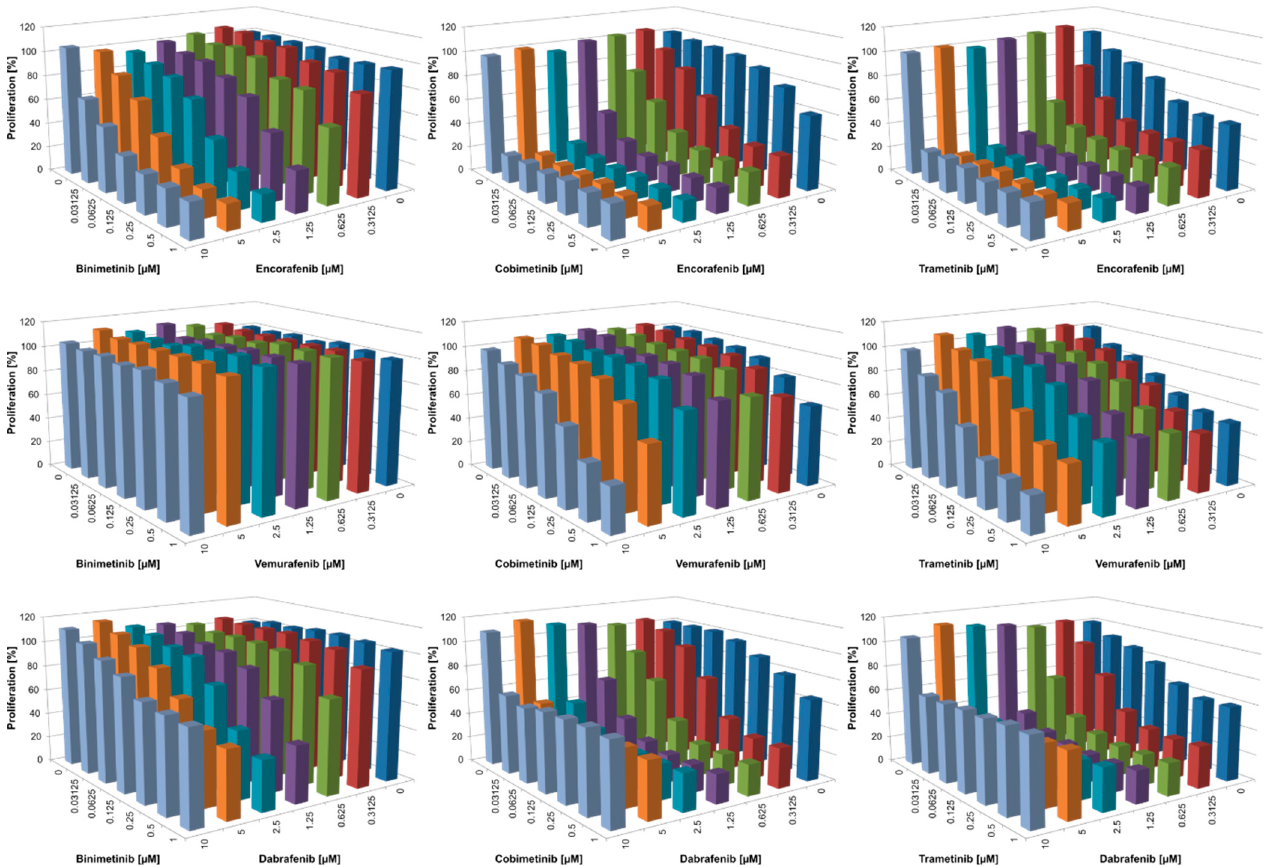
Figure 5. Inhibition of proliferation of WM1366 (NRAS mut ) after treatment for 72 h with single or combined BRAFi/MEKi (serial dilutions 1:2); n ≥ 3; for simplicity, standard deviation and significance are not shown. Significance from these data is displayed in Figures S2 and S3. List of p -values can be found in Tables S5 and S6. Table 1. Comparison of inhibitor characteristics and efficacies in the resistant cell lines and clinical